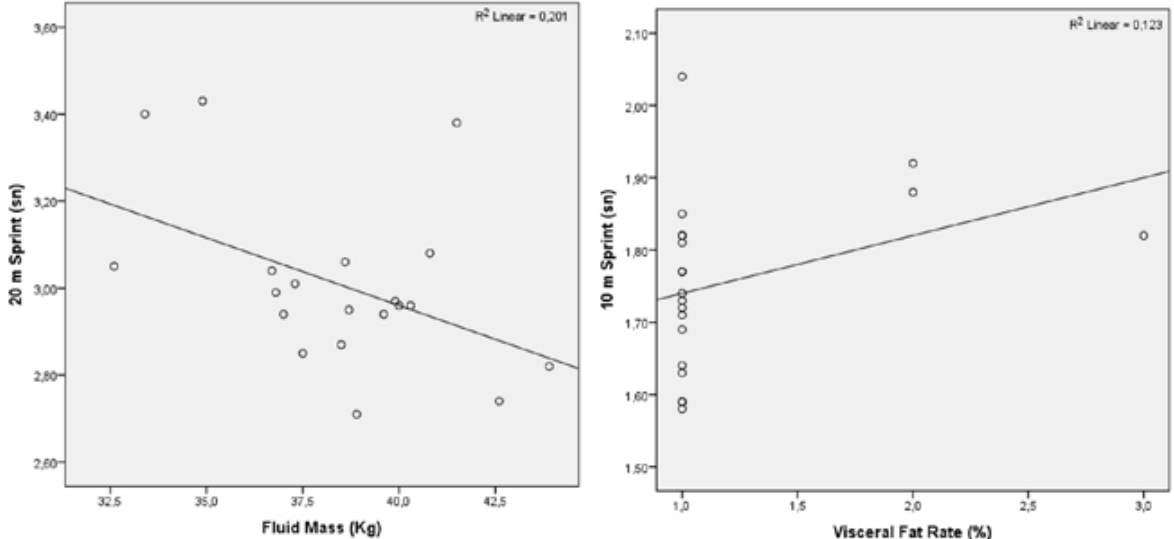
Figure 2. The relationships between lean mass and 20-m sprint (left) and visceral fat and 10-m sprint